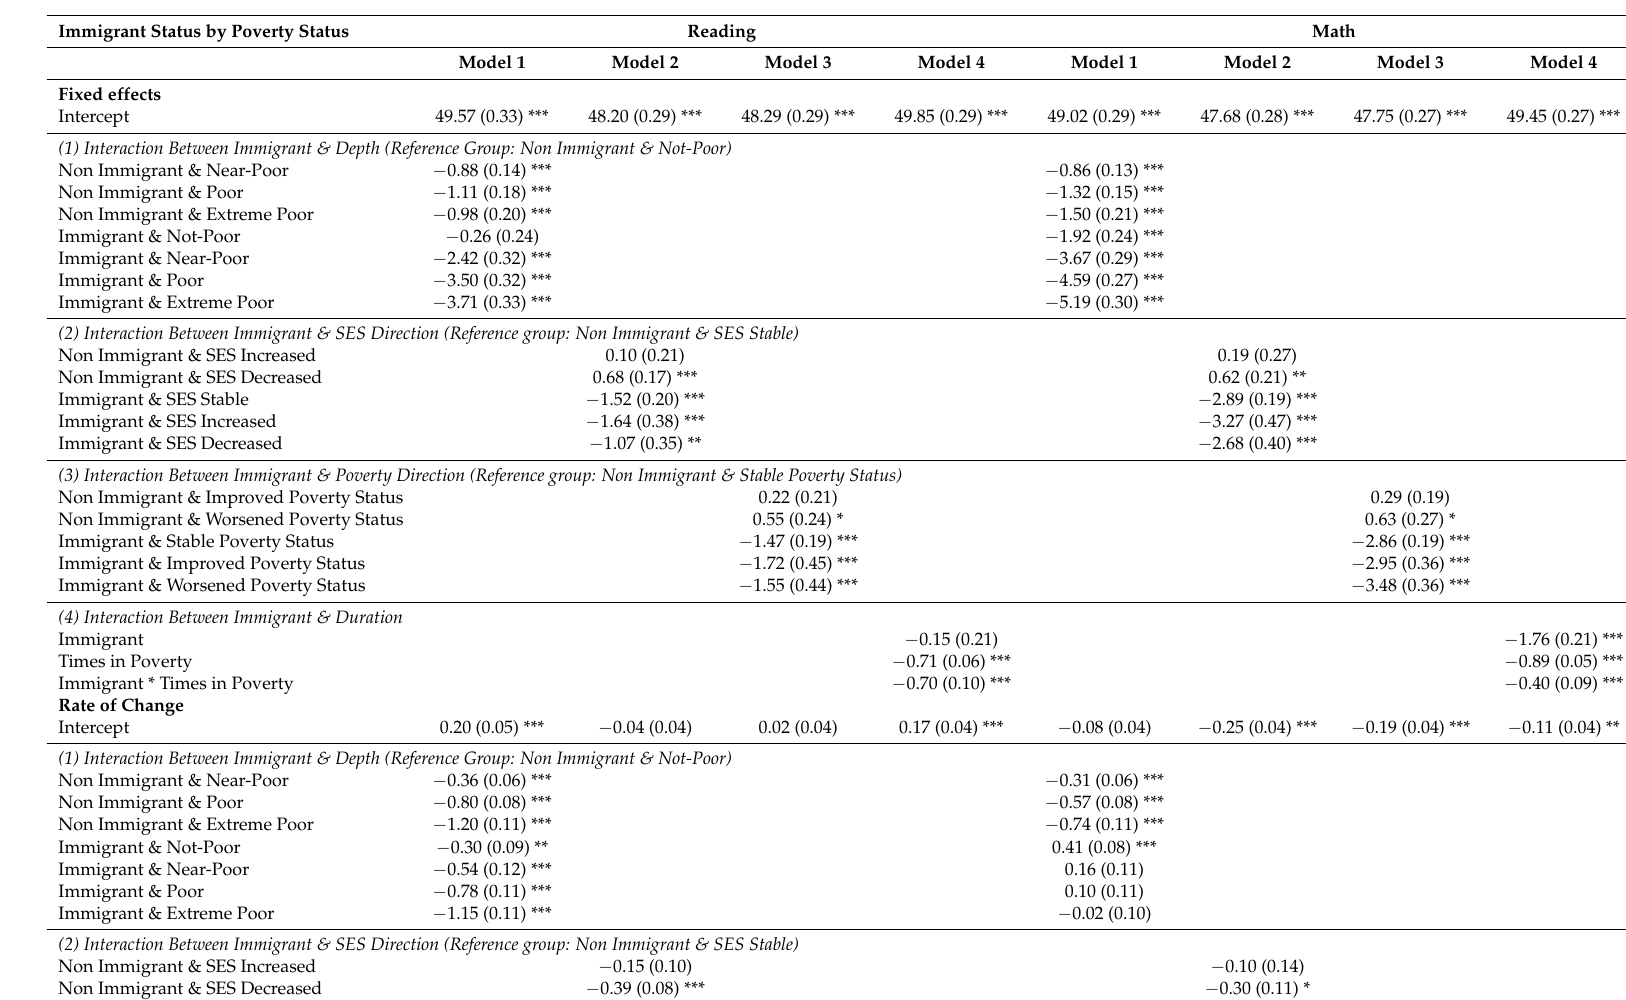
Table 5. Academic achievements from kindergarten to eighth grade by poverty dynamics and immigrant